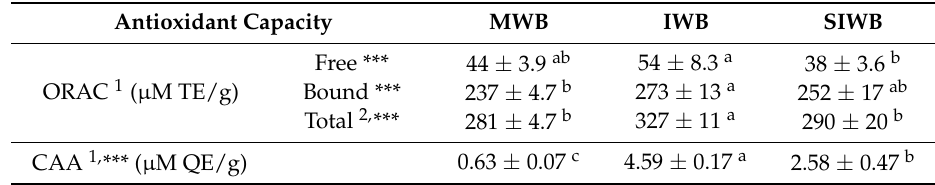
Table 2. Oxygen radical absorbance capacity (ORAC) and cellular antioxidant activity (CAA) in extracts of mature wheat bran (MWB), immature wheat bran (IWB), and steamed immature wheat bran